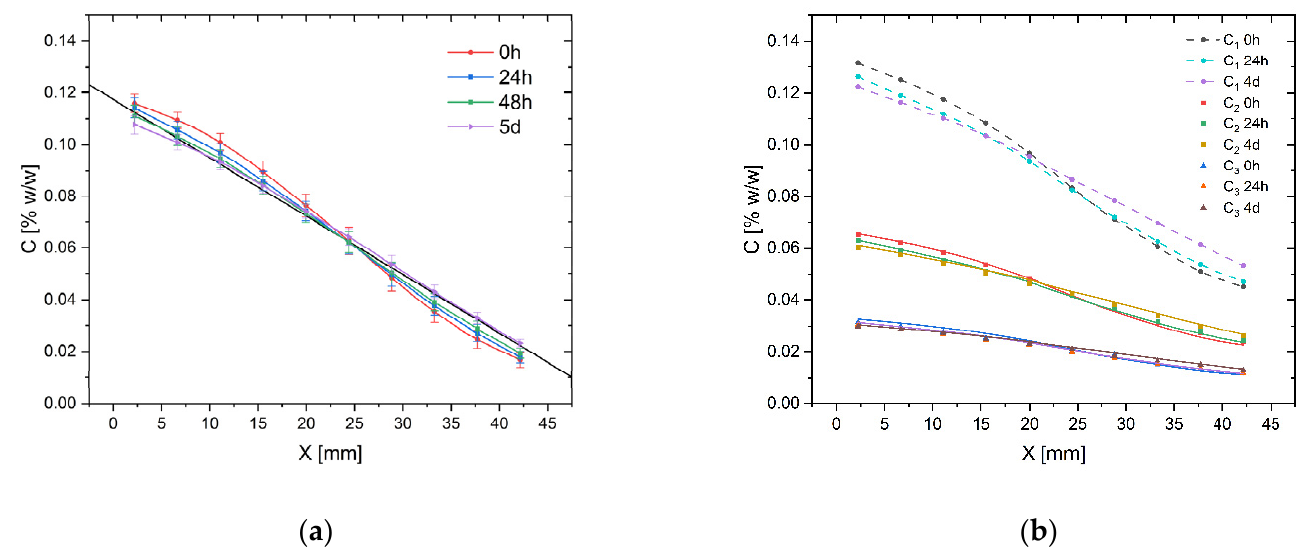
Figure 7. The gradient stability over time for 25 tilts and 4 µ L SV; ( a ) A dye concentration profile for C MIN = 0% and C MAX = 0.1333%; ( b ) A dye concentration profiles for concentration ranges: C 1 (0.1333–0.0333%), C 2 (0.0666–0.01666%), C 3 (0.0333–0.008333%). Dashed lines—reference profiles, solid lines—profiles calculated from Equation (1).